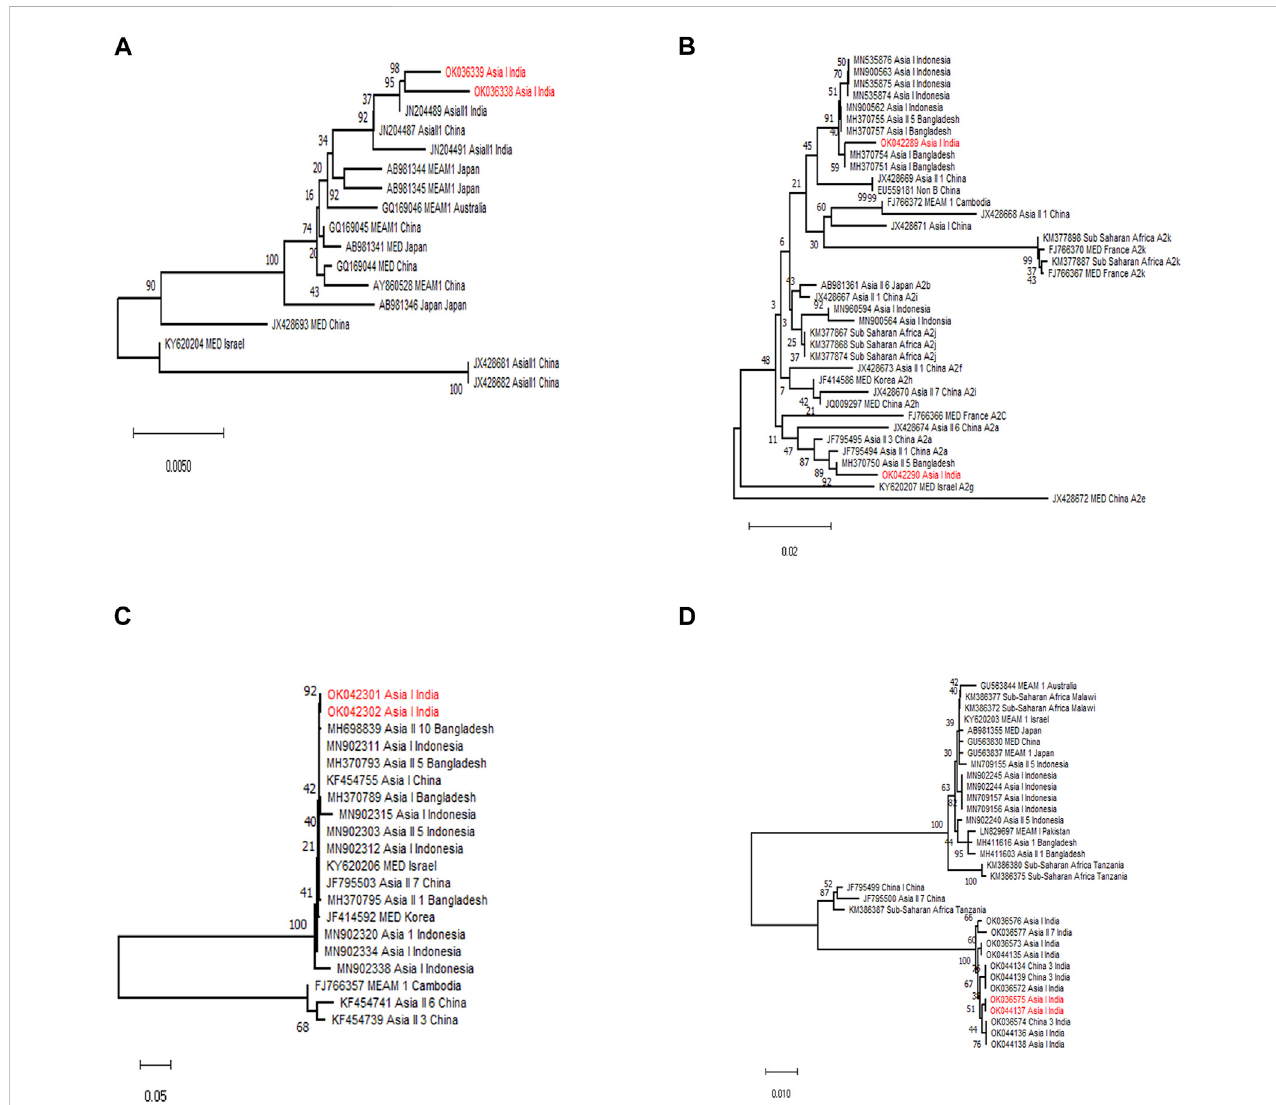
Phylogenetic tree of primary and secondary endosymbionts of B . tabaci based on 16S rDNA ( Portiera , Wolbachia , and Rickettsia ) and 23S rDNA ( Arsenophonus )gene segments. The samples from thestudy are indicated by bold text (red) inthe tree; all other sequences were obtained from the GenBank database. (A) Maximumlikelihoodphylogenetictreeofthe16SrDNAsequencesof Portiera sp.infectingdifferentwhite fl ypopulations. (B) Maximumlikelihood phylogenetictreeofthe23S rDNA sequences of Arsenophonus sp.infecting differentwhite fl ypopulations. (C) Maximum likelihood phylogenetictree of the 16S rDNA sequences of Wolbachia sp. infecting different white fl y populations. (D) Maximum likelihood phylogenetic tree of the 16S rDNA sequences of Rickettsia sp. infecting different white fl y